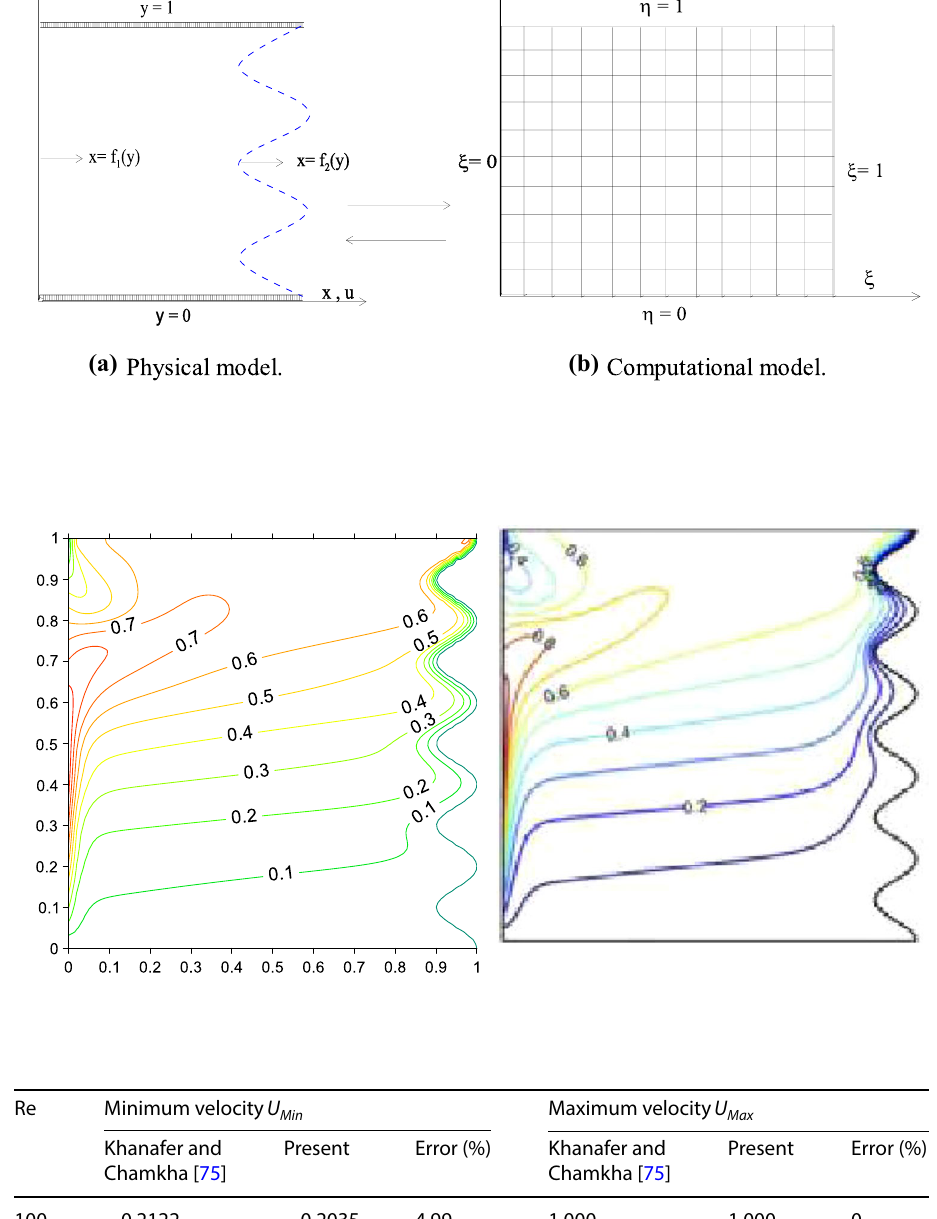
Fig. 2 Mapping between physical and computational